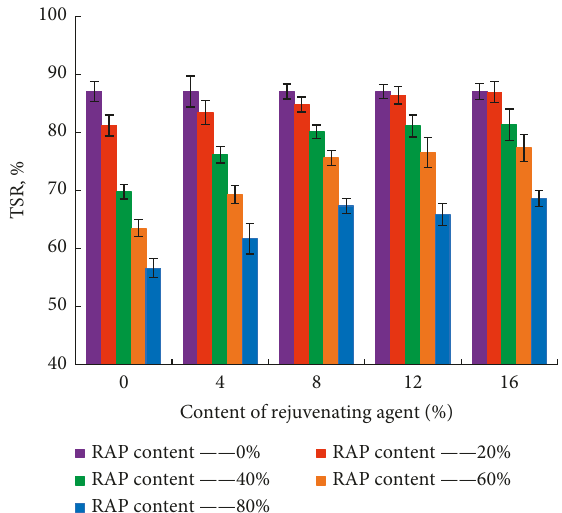
Figure 4: TSR test results with different content of